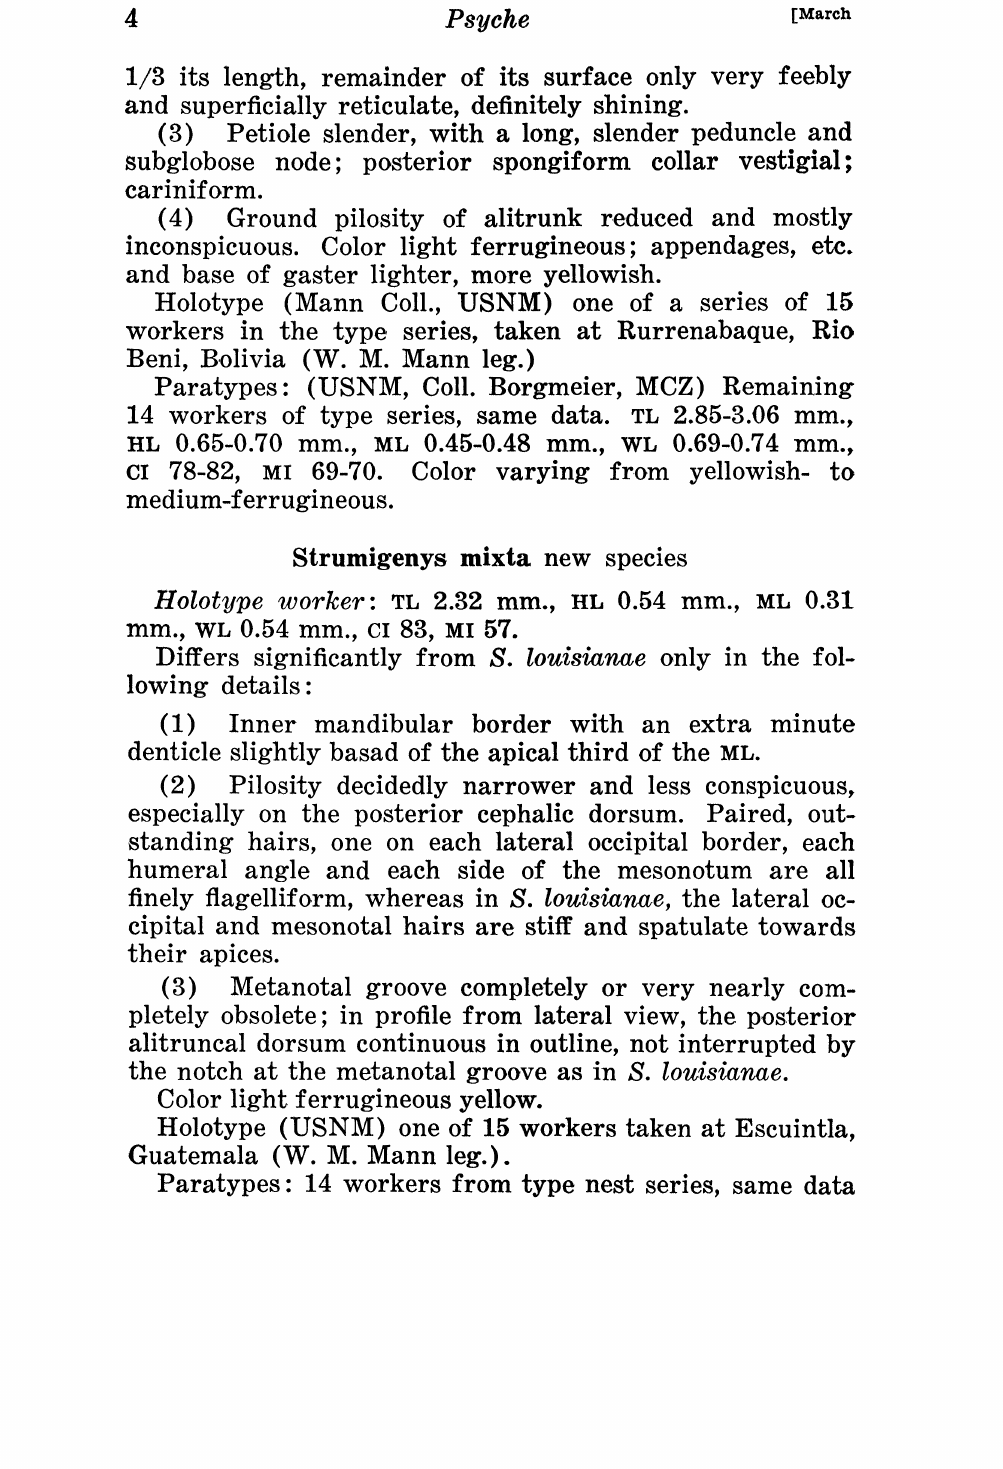
the notch at the metanotal groove as in S.